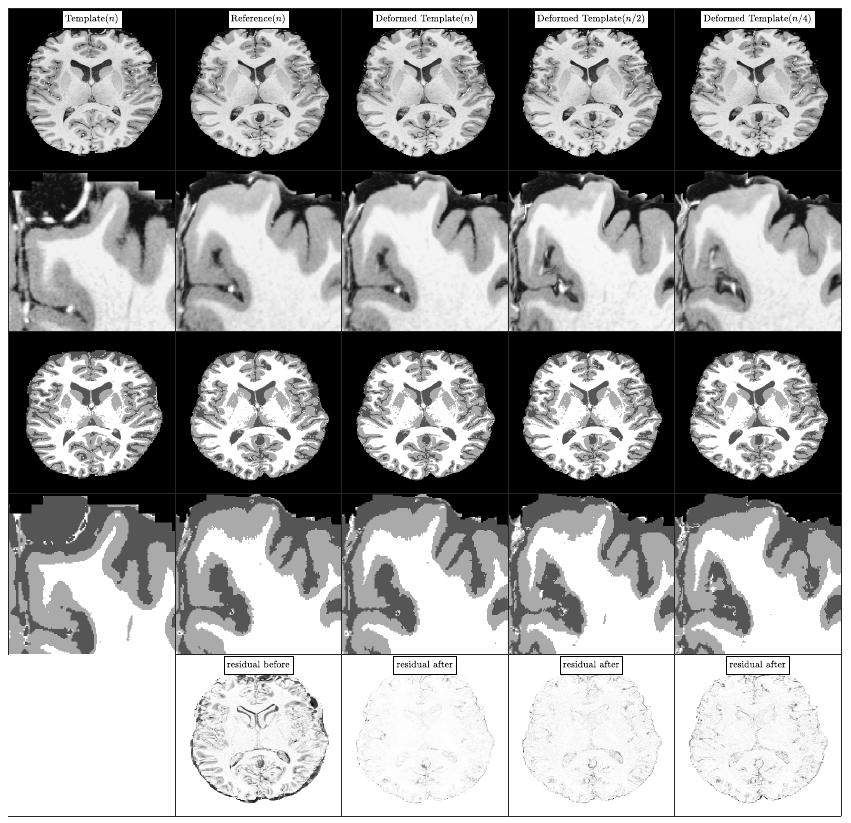
Figure 7. Experiment 2B: Illustration of registration results for the multi-resolution registration experiment on real brain images. The images shown here correspond to the runs #1, #2, and #3 in Table 7). The base resolution is n x = n = ( 640,880,880 ) . In row 1, from left to right, we show the T 1 -weighted MRI250 datasets (template image m 0 ), the upsampled na01 dataset (reference image m 1 ) from the NIREP data repository, and the deformed template images obtained from registration at resolutions n x , n x /2, and n x /4, respectively. In row 2, we show a cropped portion of the images from row 1. In rows 3 and 4, we show the label maps consisting of white matter (WM; white), gray matter (GM; light gray), and cerebro-spinal fluid (CSF; dark gray) and their cropped versions, respectively. In row 5, we show the image residuals before and after registration with respect to each resolution